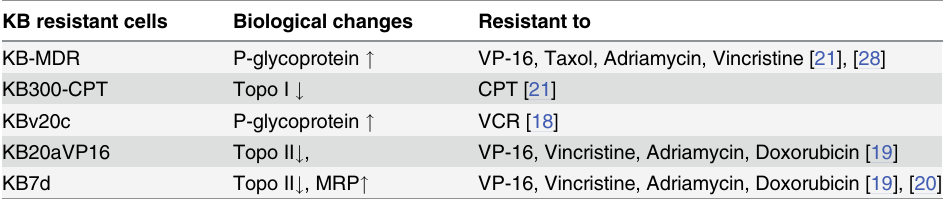
Table 1. Characteristics of different KB resistant cell